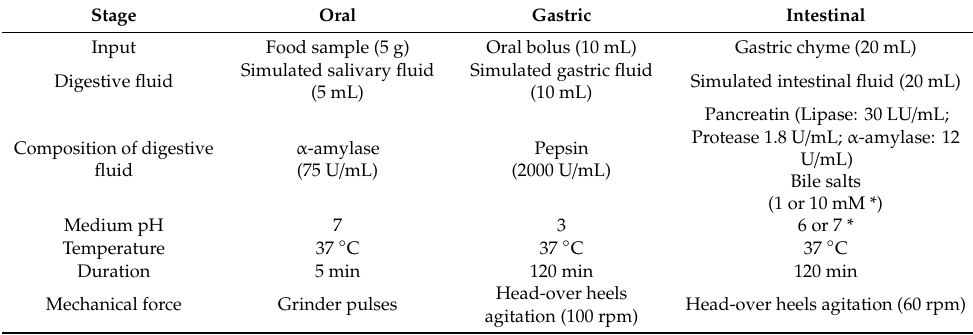
Table 1. Overview of the parameters defining the oral, gastric and intestinal stages of the in vitro digestion